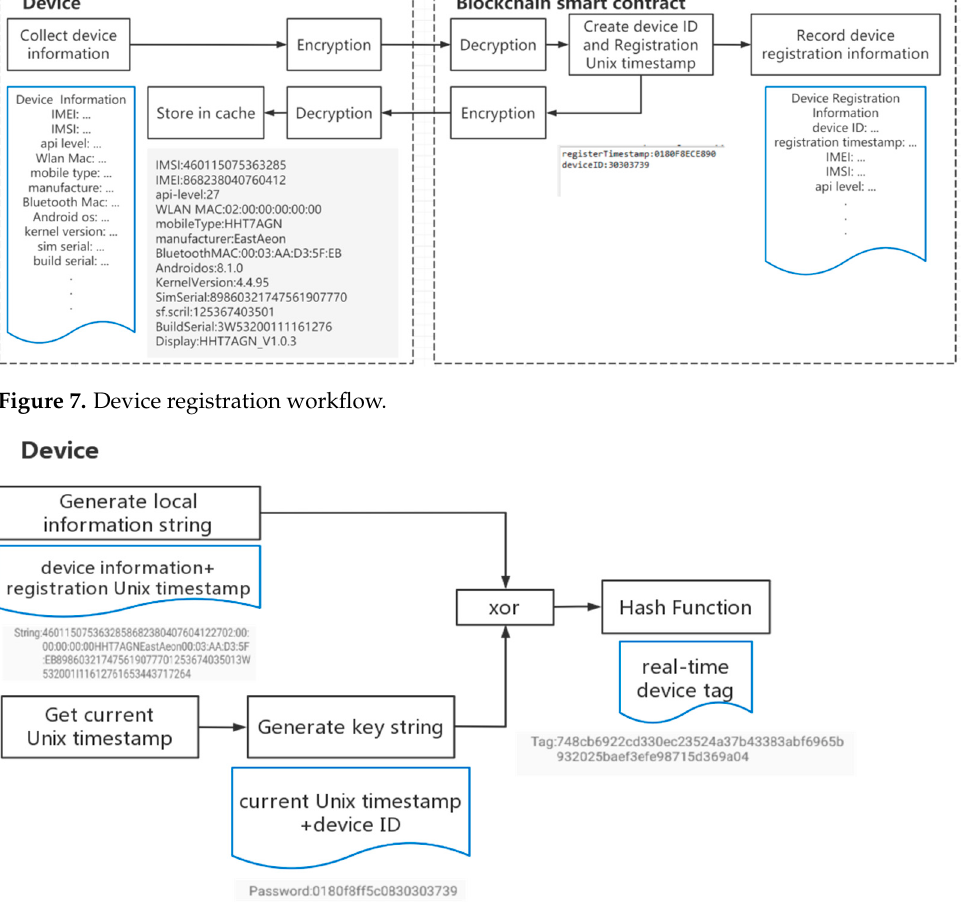
Figure 8. Real-time tag creation workflow.